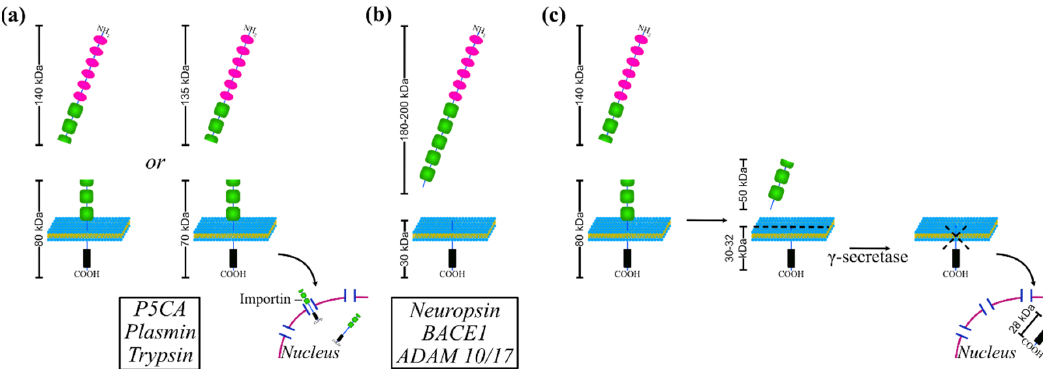
Figure 2. Processing of L1CAM. (a) Full-length L1CAM undergoes a cleavage inside the FN3 repeat by serine proteases PC5A, plasmin or trypsin. Thus, a soluble fragment of about 135-140 kDa (top) and another of 75-80 kDa are produced. The former is released while the remaining fragment, which comprises part of the ectodomain, the transmembrane domain and the cytoplasmic domain, is internalized and imported into the nucleus via importin. (b) L1CAM is cleaved closer to the membrane by neuropsin, BACE1 or ADAM10/17 proteases generating a soluble fragment of about 180-200 kDa (top) and one of 30 kDa. (c) The processes described in (a) and (b) can occur sequentially. First, L1CAM is cleaved inside the FN3 repeat; a second cut occurs close to the membrane producing a fragment of 50 kDa and another of 30-32 kDa, which remains anchored to the membrane. The latter is further processed by γ -secretase and is released from the plasma membrane, eventually translocating into the nucleus.